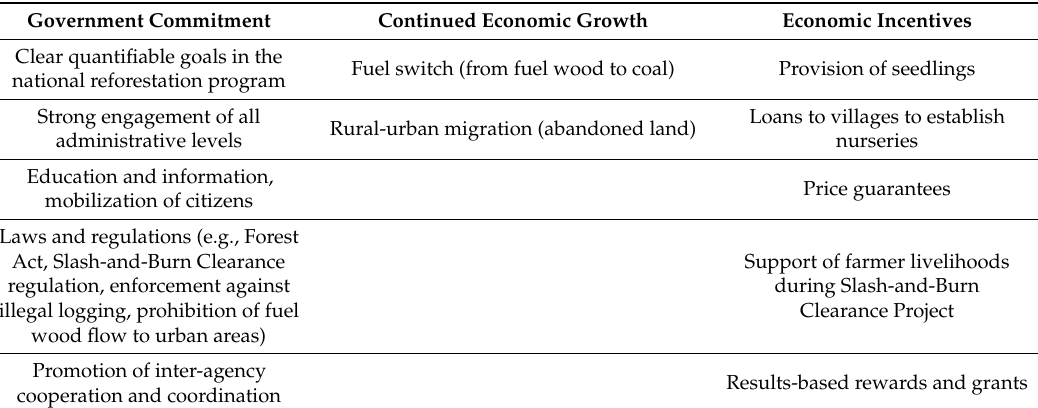
Table 1. Drivers of success of the South Korean forestation programs (data from